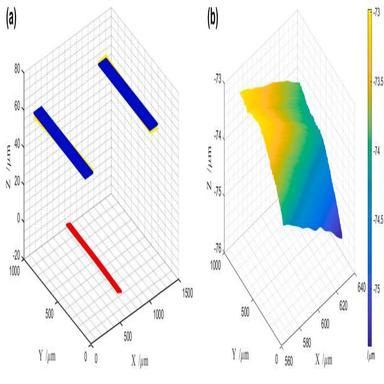
Data visualization in Experiment 1: (a) the fitted datum plane indicated by blue color; (b) false color plot of the bottom plane (in red in (a)) after subtracting the datum plane. (For interpretation of the references to color in this figure legend, the reader is referred to the Web version of this article.)